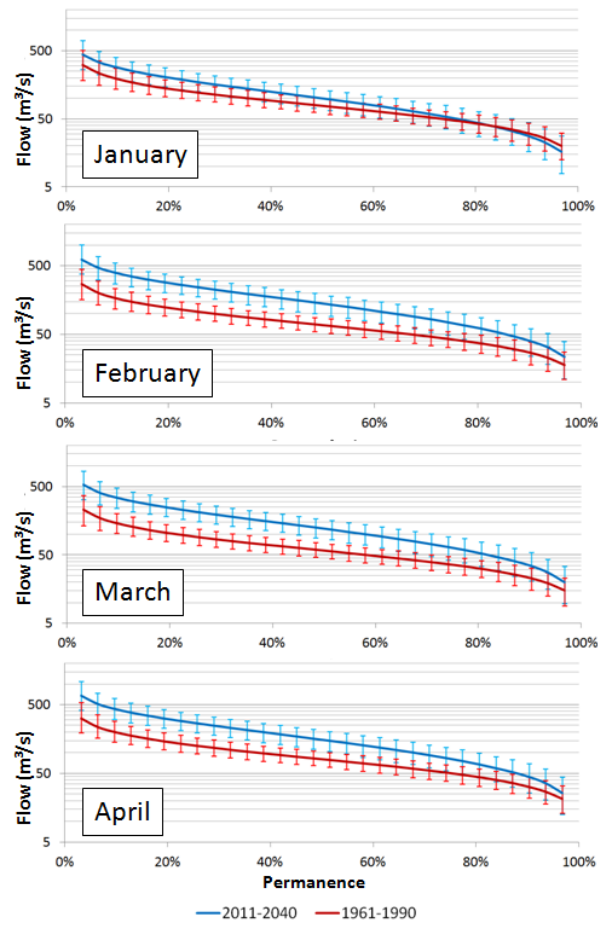
Figure 9. Mean and 90% confidence interval for the monthly flow permanence curves at Santo Ângelo gauge station, according to the stochastic series generated in the base period (1961–1990) and fu- ture period (2011–2040): January, February, March and